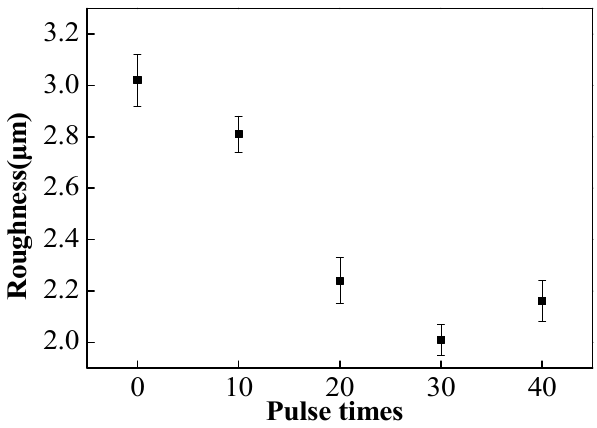
Figure 4. The surface roughness of samples before and after HCPEB irradiation.